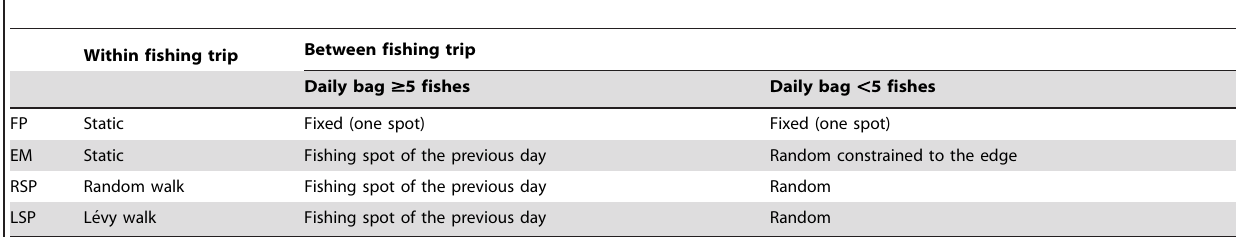
Table 1. Characteristics of the movement within (15 min time steps) and between fishing trips in the four fisher behaviours: the fisher fixed in one spot (FP), the fisher moving in the edge of the scenario (EM), the random search pattern (RSP) and the Le´vy search pattern (LSP). The daily bag was used as a proxy of the fishing spot quality and as a criterion for changing the fishing spot of the next fishing